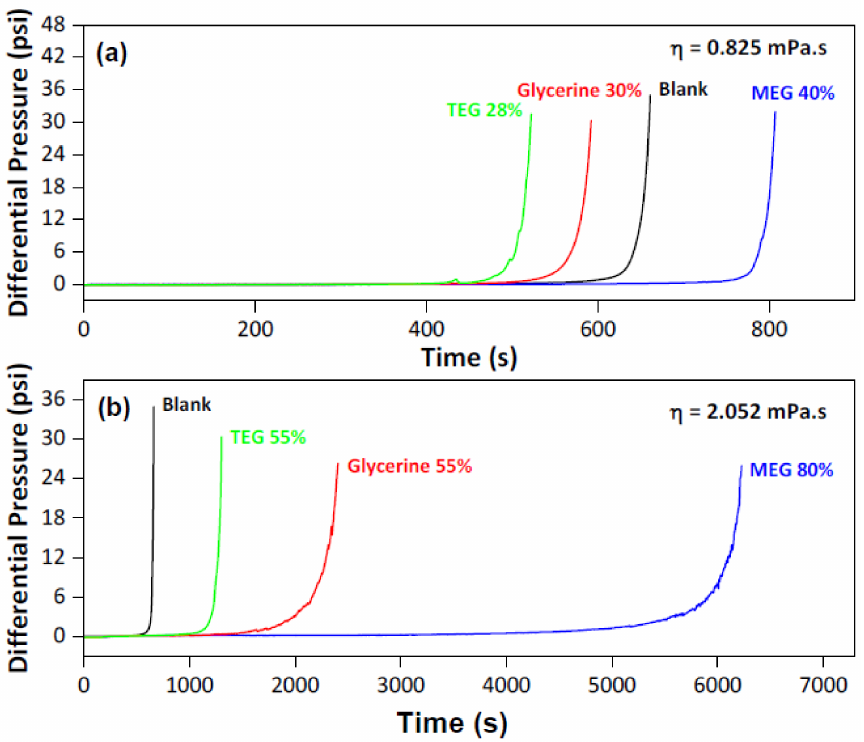
Figure 5. Differential pressure profiles for comparison of different systems with the same viscosity, where the system’s viscosities are: ( a ) 0.825 mPa s, and ( b ) 2.052 mPa